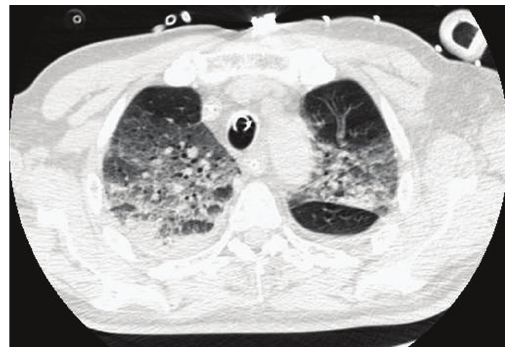
Figure 2: CT scan of the chest obtained on Day 1 showing di ff use bilateral alveolar infiltrate.